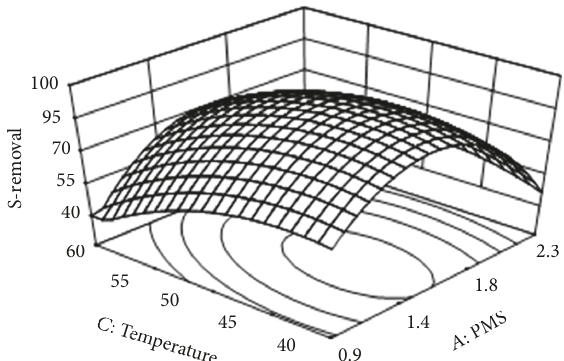
Figure 3: The response surface plot about effect of PMS and temperature interaction on